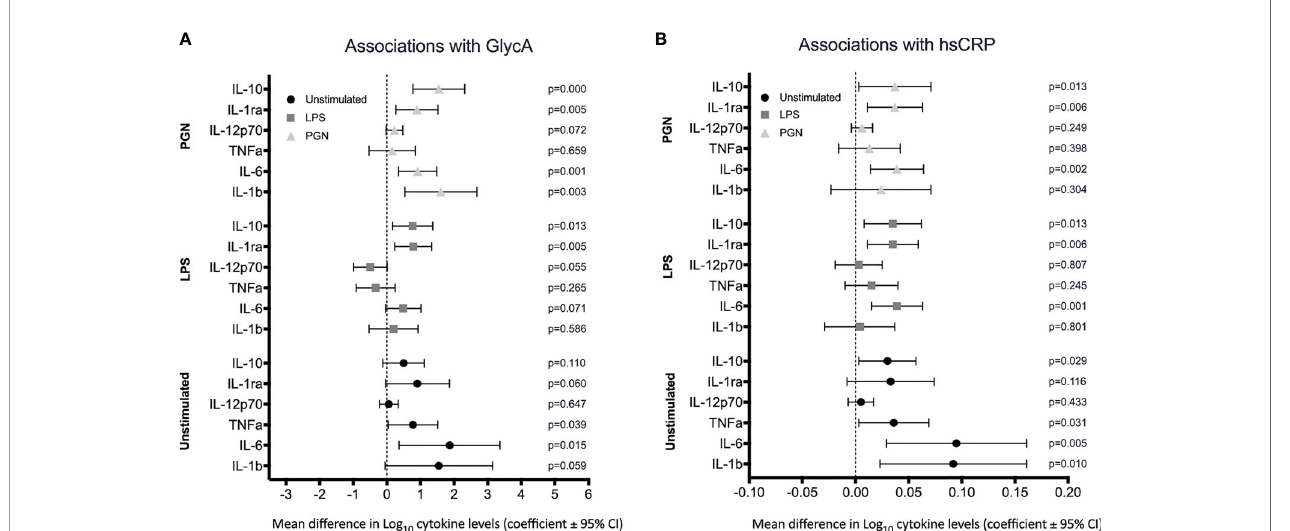
FIGURE 2 | Association between circulating in fl ammatory markers GlycA and hsCRP and cytokine levels. Cytokines were quanti fi ed following stimulation of whole blood in either media (unstimulated) or TLR ligands, LPS and PGN. The estimated mean differences in cytokine levels (Log 10 (pg/ml)) were calculated per 10-fold difference in (A) GlycA, Log 10 (mmol/L) and (B) hsCRP, Log 10 (µg/ml). Linear regression analyses of cytokine level on in fl ammatory marker adjusted for sex, age and innate immune cell populations (as determined a priori).